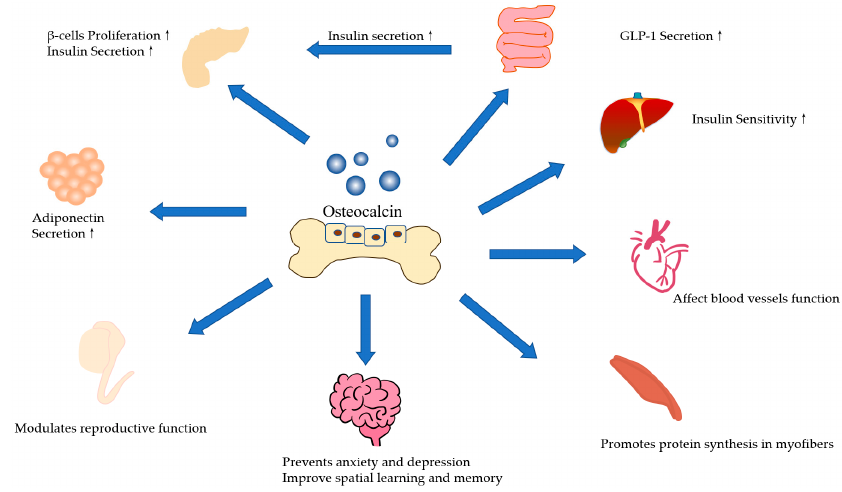
Figure 1. The diagram depicting the endocrine function of osteocalcin in different organs [59]. Excessive deposition of triglycerides in the liver and inhibition of fatty acid oxidation result in the destroying of the homeostasis of lipid metabolism [60]. ucOCN functionally